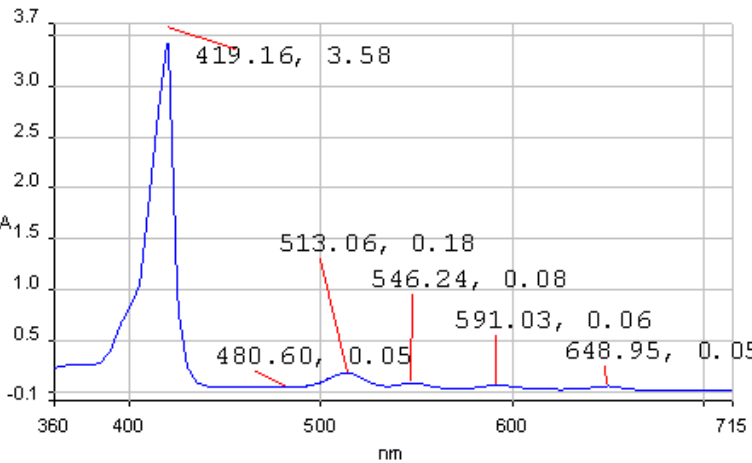
Figure 1. The absorption spectrum of 1a in THF, c = 3.24×10 -5